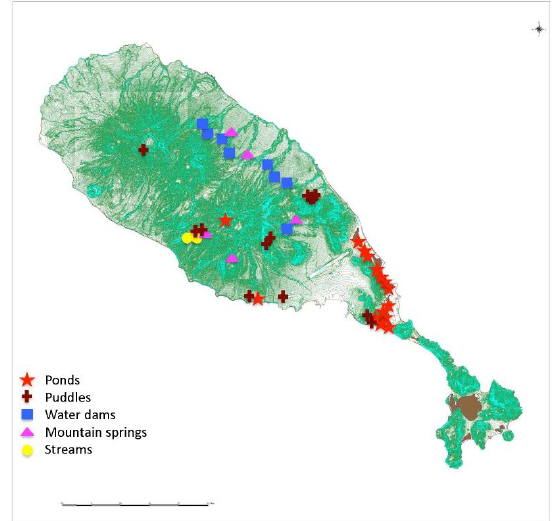
Figure 1. St. Kitts map showing sampling areas and types